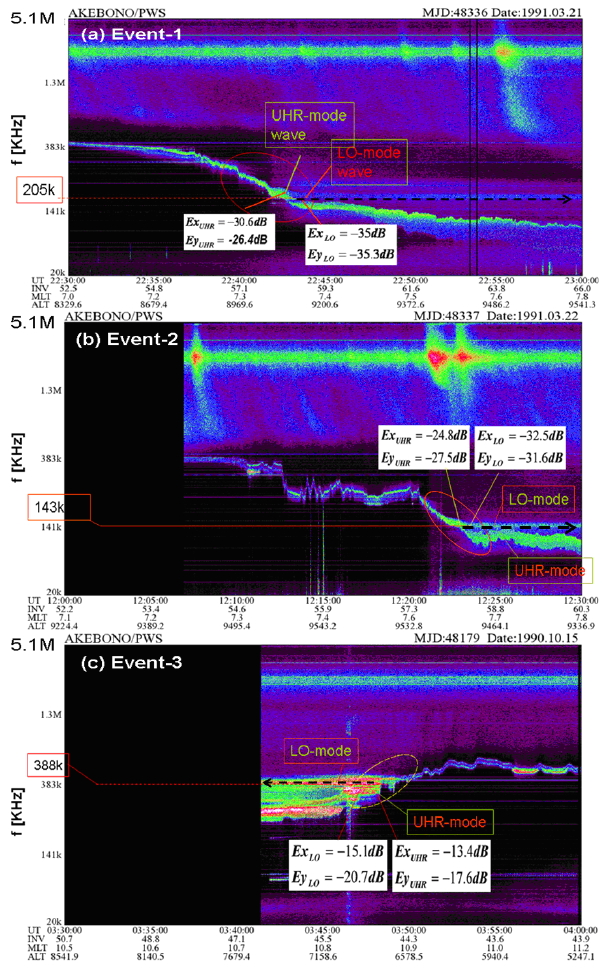
Fig. 1. Akebono satellite observation of plasma waves around the plasmapause. The figures indicate three examples of the dynamic spectrum, that LO-mode can be generated by mode conversion pro- cess. We focus on the area inside the circles shown in each panel.